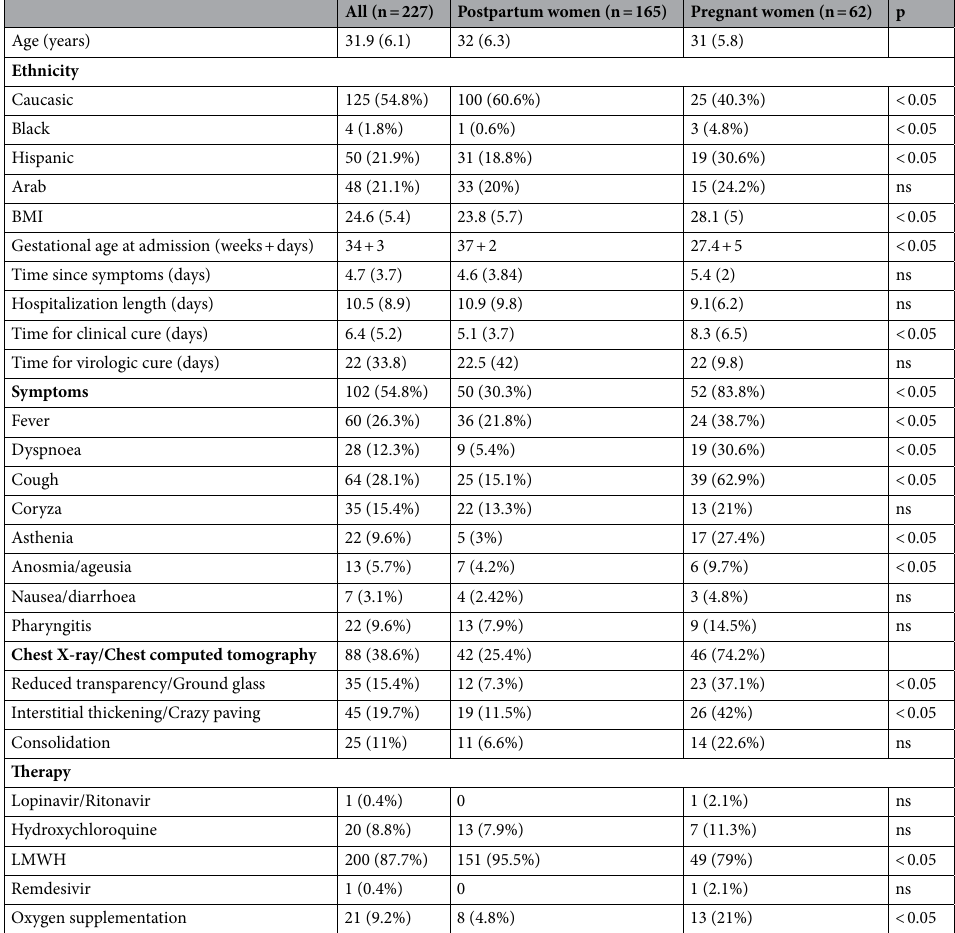
Table 1. Demographic and clinical characteristics of obstetric patients with COVID-19. Among pregnant women are included those patients who did not deliver during hospitalization, among postpartum women those who did. All data are expressed as mean with standard deviation. ( BMI body mass index, LMWH low- molecular-weight heparin, CPAP continuous positive airways pressure, ICU intensive care